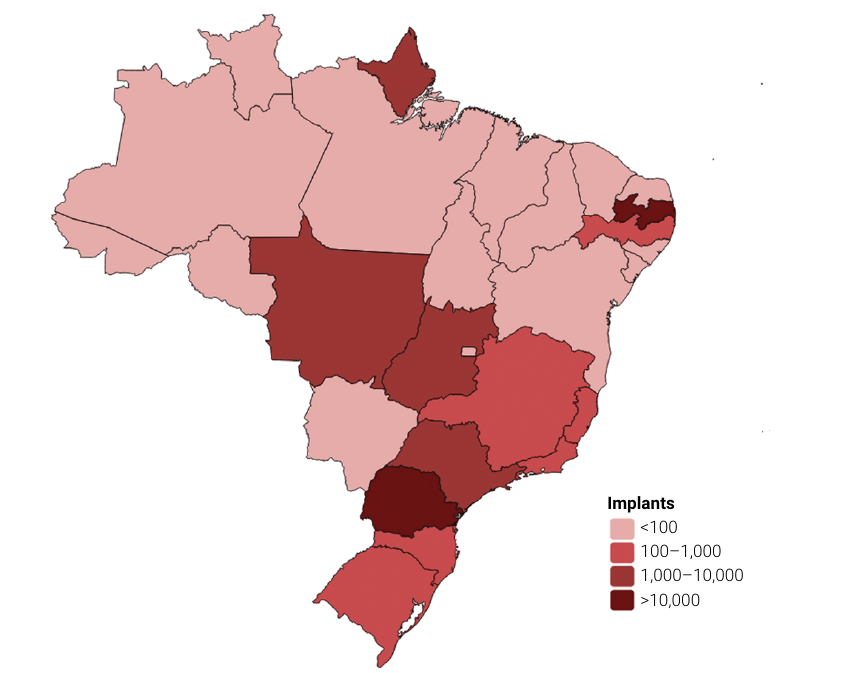
Figure 1. Heat-map of the distribution of dental implants provided by SUS for each Brazilian state.